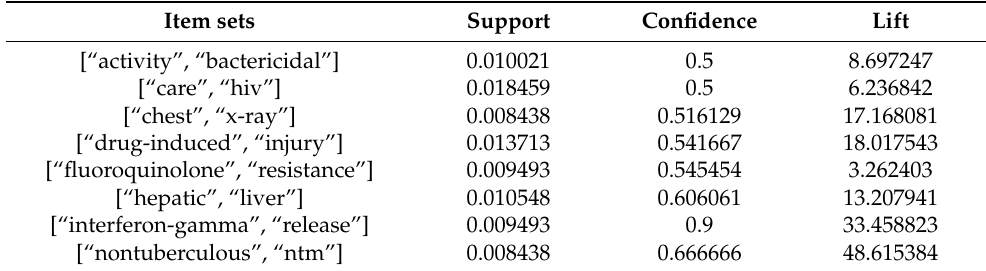
Table 9. Sample item sets of isoniazid dataset.